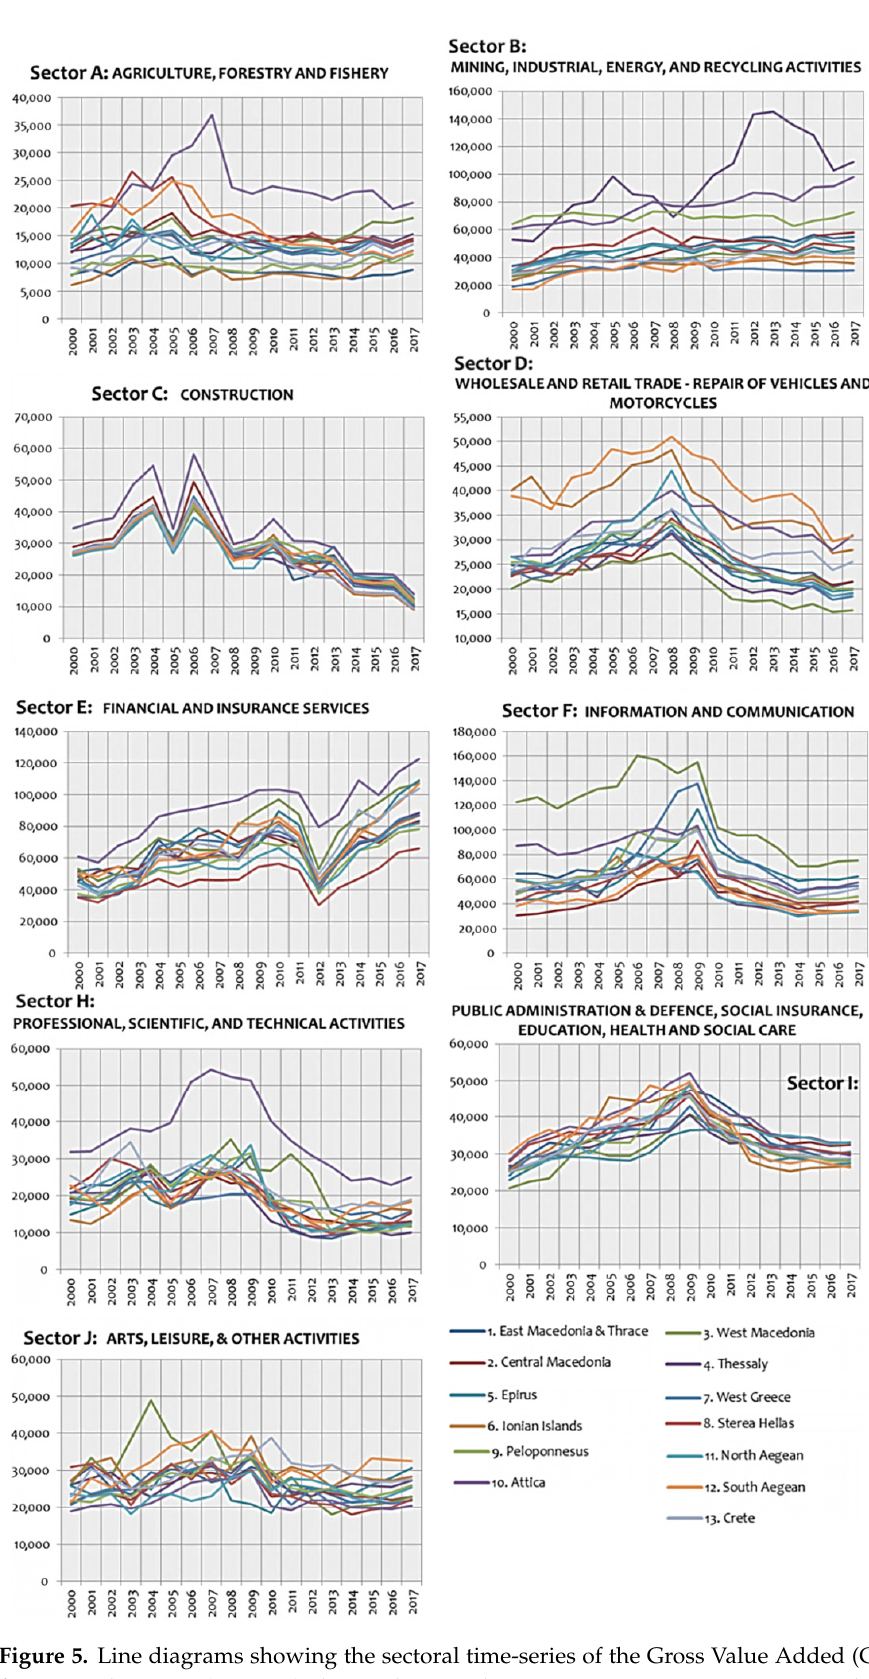
Figure 5. Line diagrams showing the sectoral time-series of the Gross Value Added (GVA) (pLU) for 13 Greek regions (NUTS II), during the period 2000–2017. GVA prices are measured in EUR/LU (constant prices on 2008 basis).